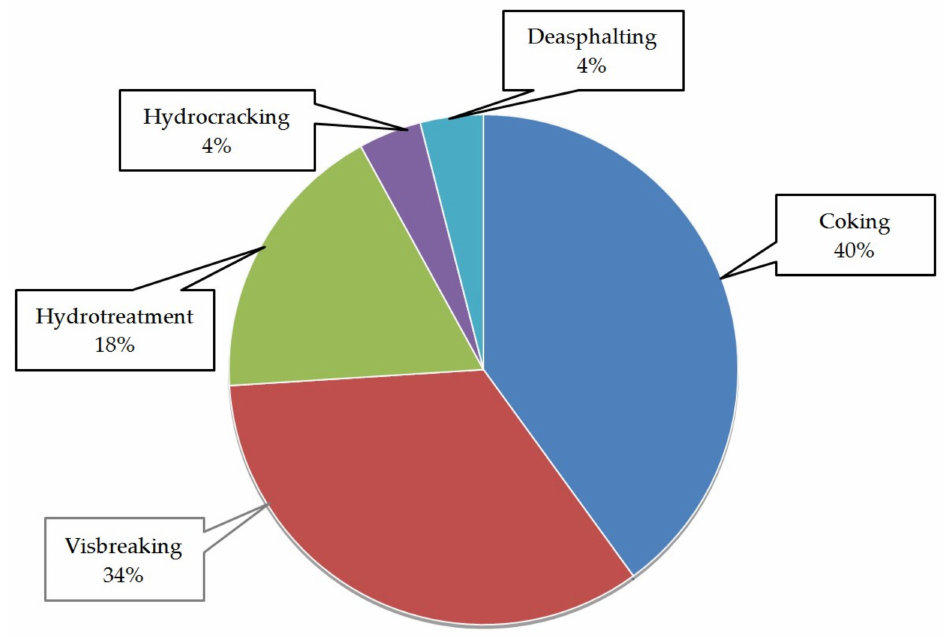
Figure 2. Global HRS upgrading